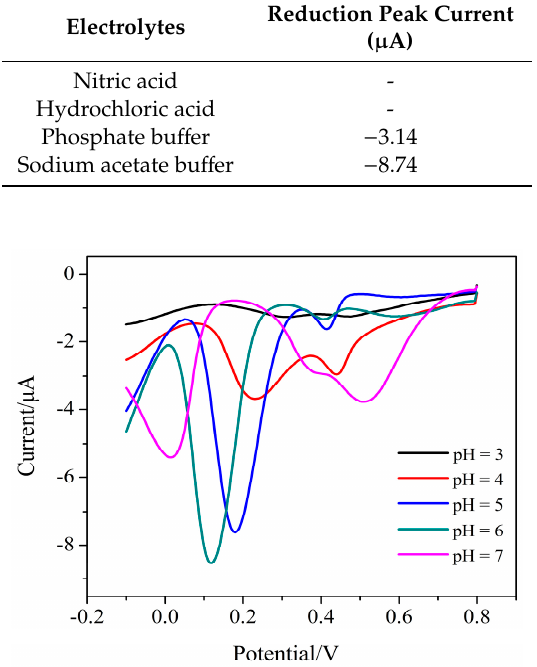
Figure 8. The effect of pH on the current response of Cr (VI) detection (pulse size = 25 mV, frequency = 25 Hz, step size = 5 mV, 0.1 mol/L sodium acetate buffer).